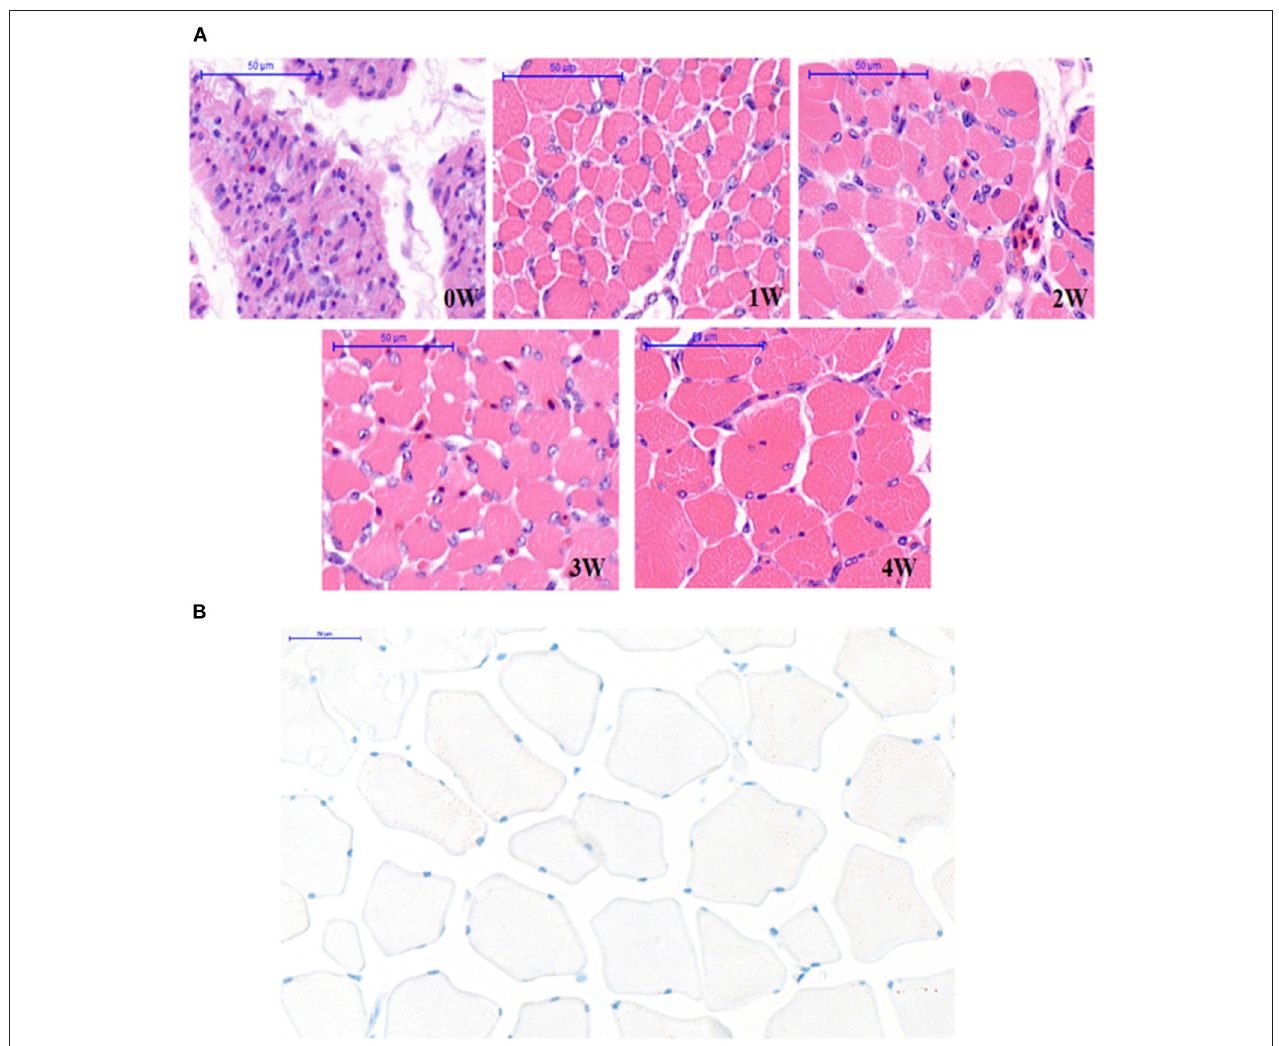
FIGURE 2 | Section of pectoral muscle tissue. (A) The breast muscle fiber morphology of pigeons ( n weeks after hatching (40 ). Scale bar: 50 µ m. (B) Oil red O staining of frozen sections of pigeon breast muscle of 4 weeks ( n ×